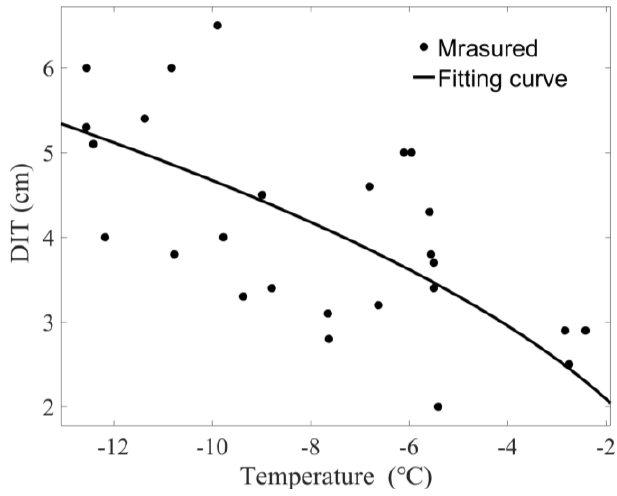
Figure 4. Statistical relationship between DIT and temperature.